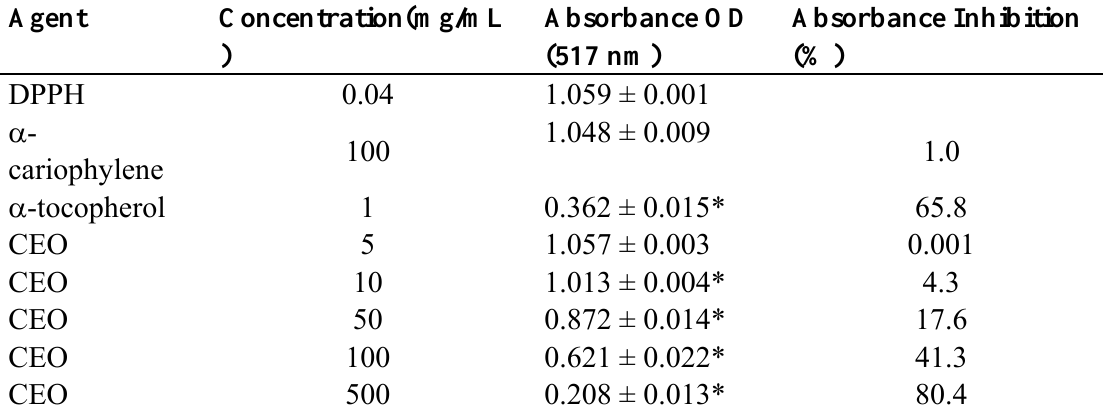
Table 3. Free radical scavenging capacity of chamomile essential oil (CEO) determined with the DPPH